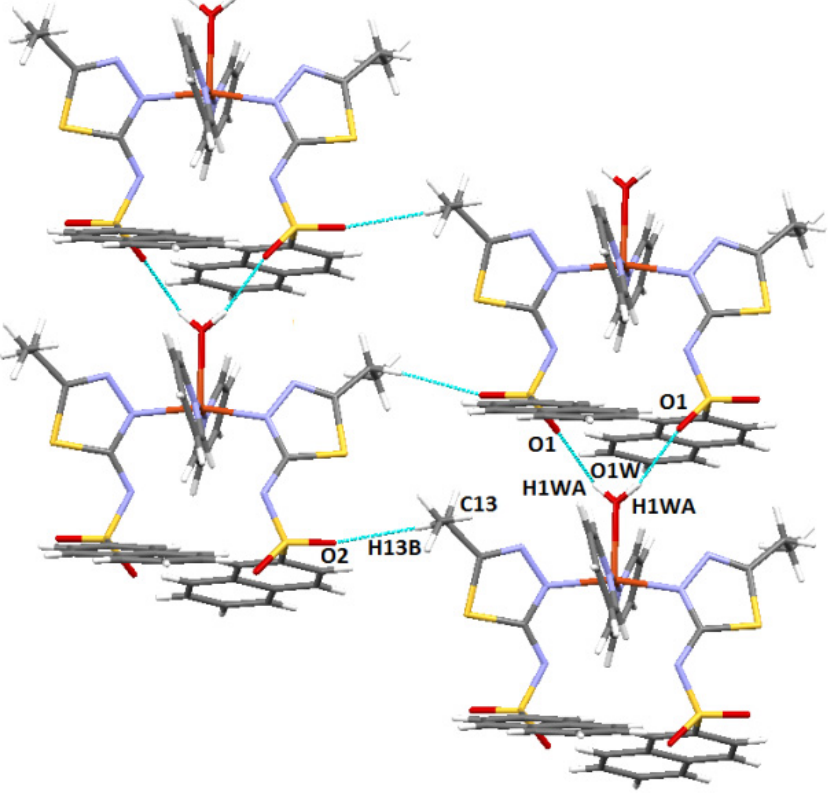
Figure 8. Intermolecular interactions in complex C2 .